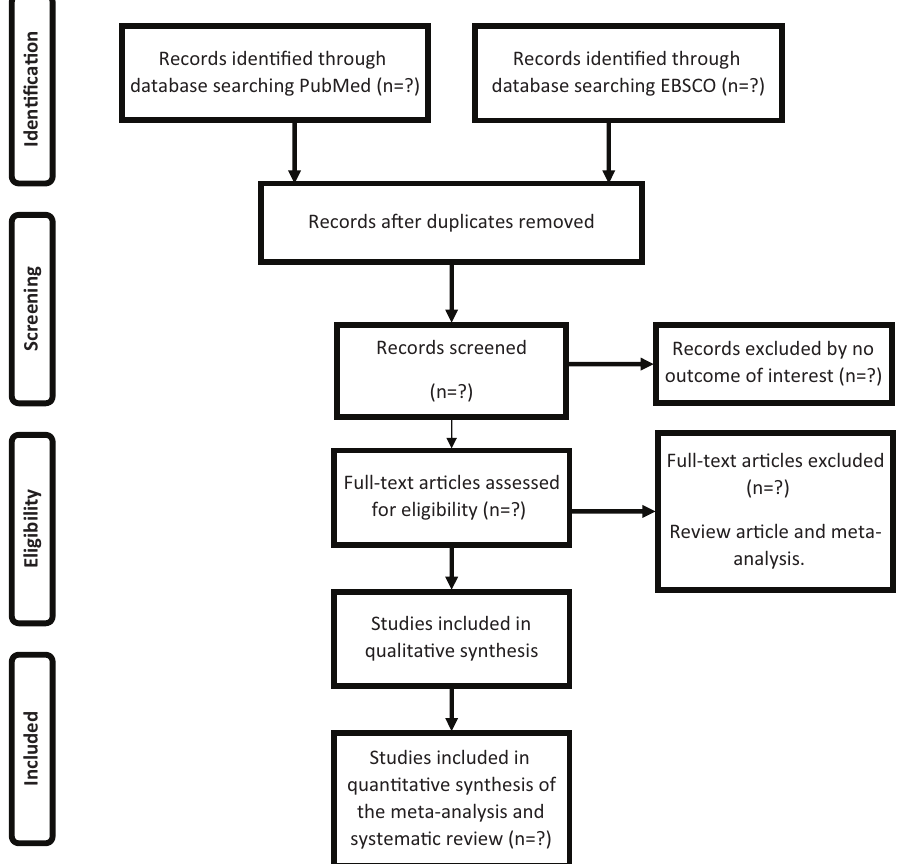
Figure 1. Flow chart for the search strategy and the inclusion/exclusion criteria used in the meta-analysis and systematic